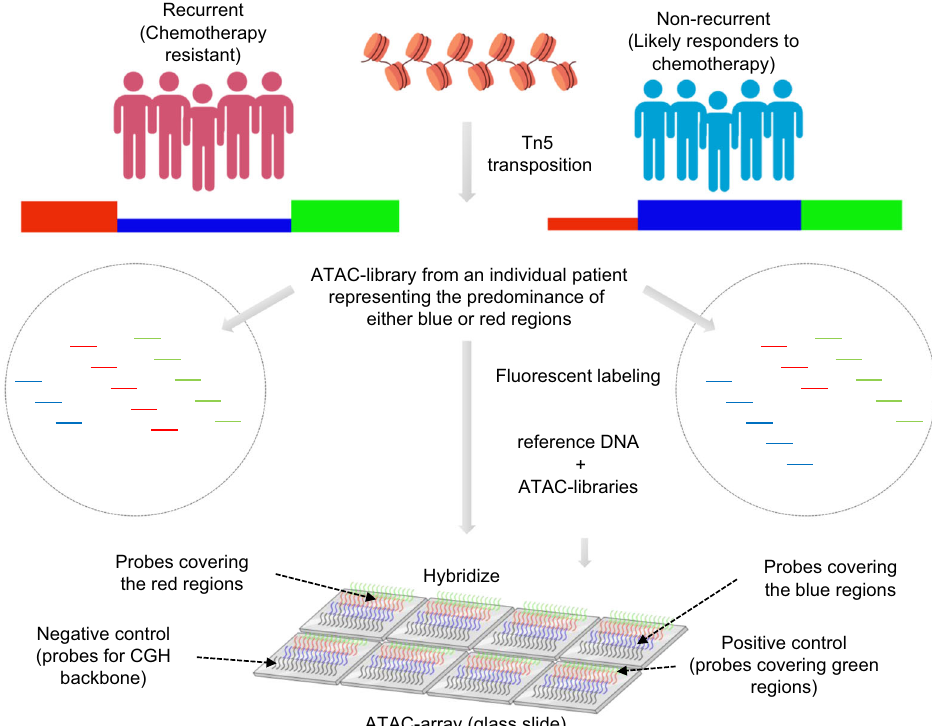
Fig. 3 ATAC-array design. Schematic diagram showing the design of the ATAC-array (illustrations were done using BioRender (drawn by